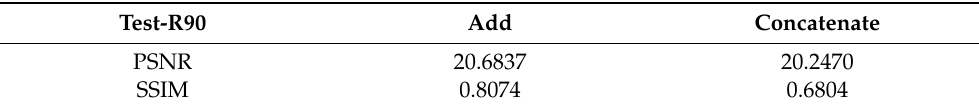
Table 9. Test results of the Mixed dataset. Using aggregation and concatenate connection between encoder and